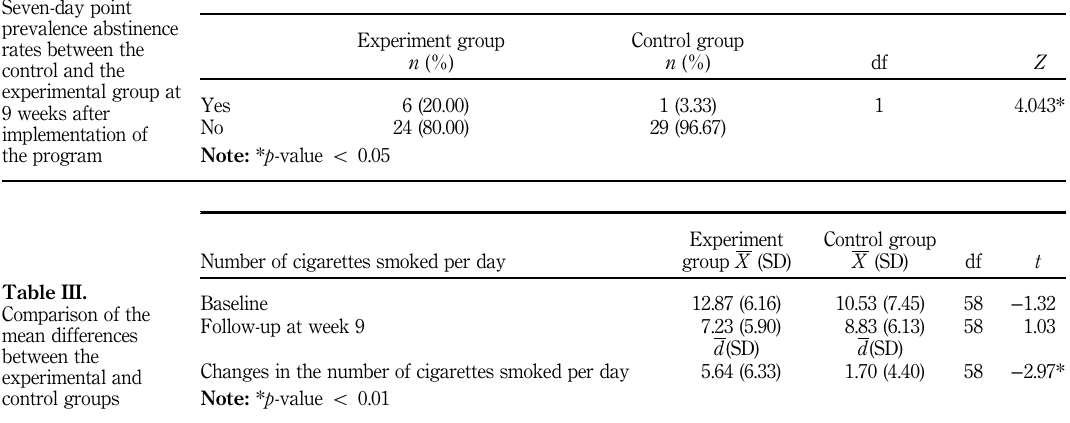
Control group n (%)